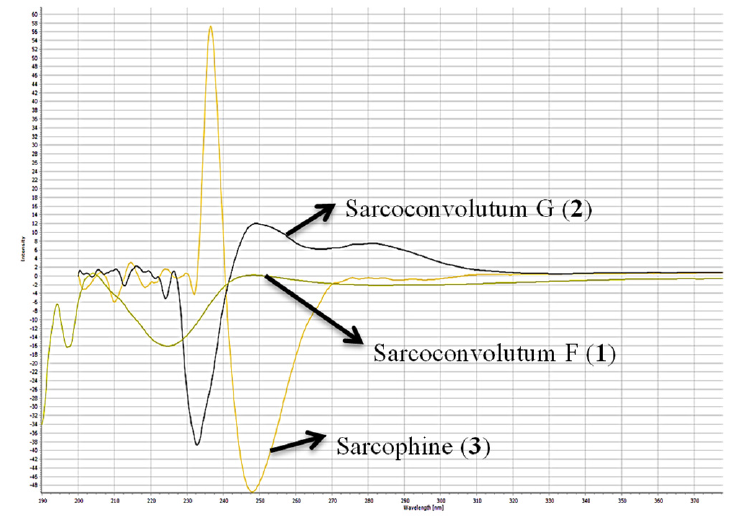
Figure 4. Circular dichroism (CD) spectra of ( 1 – 3 ).